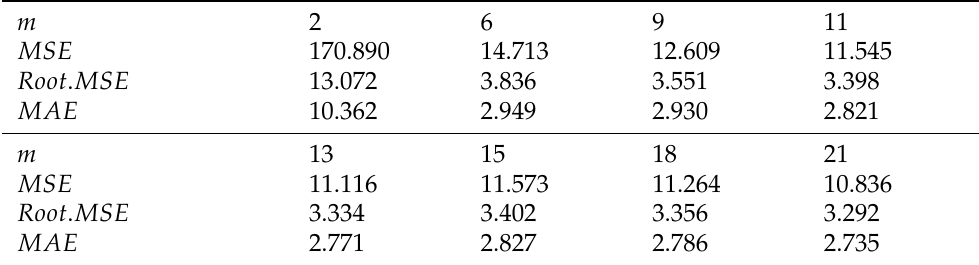
Table 3. Mean square error ( MSE ), root mean square error ( Root . MSE ) and mean absolute error ( MAE ) for risk score estimates when adjusting m regressions.